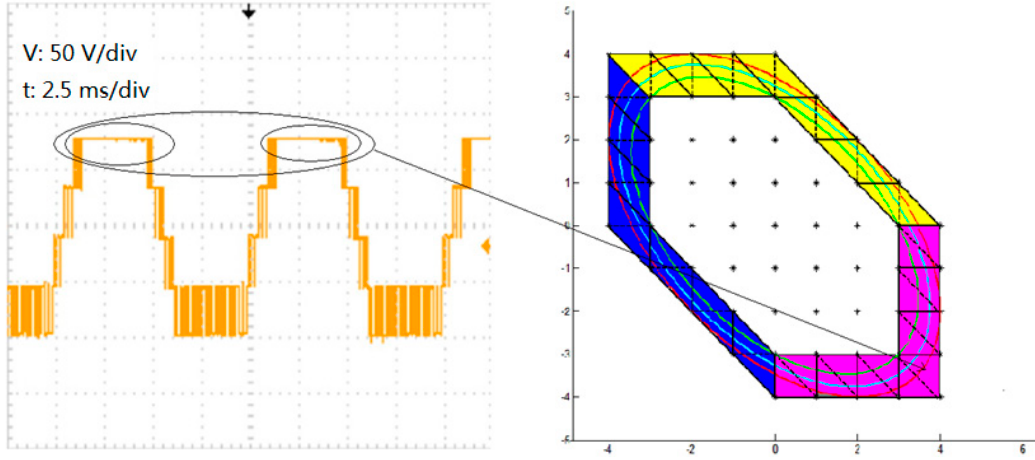
Figure 20. Corresponding graph on unchanged parts of the phase voltage A and traversing graph.